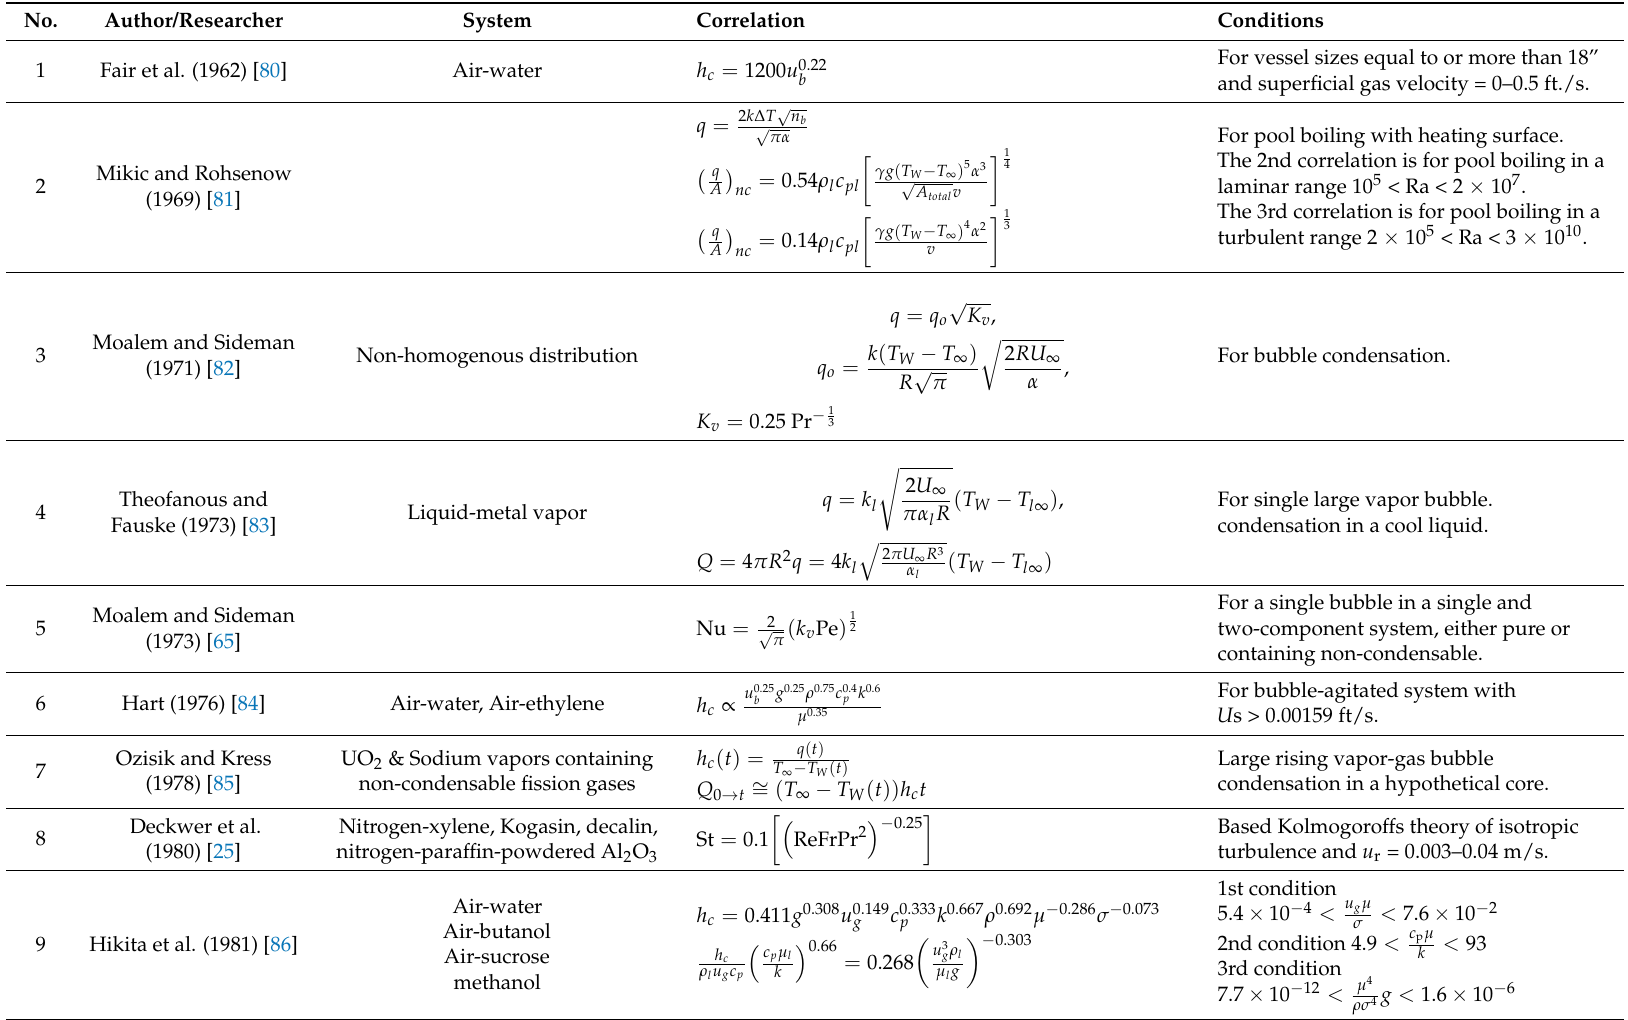
Table 3. Heat transfer